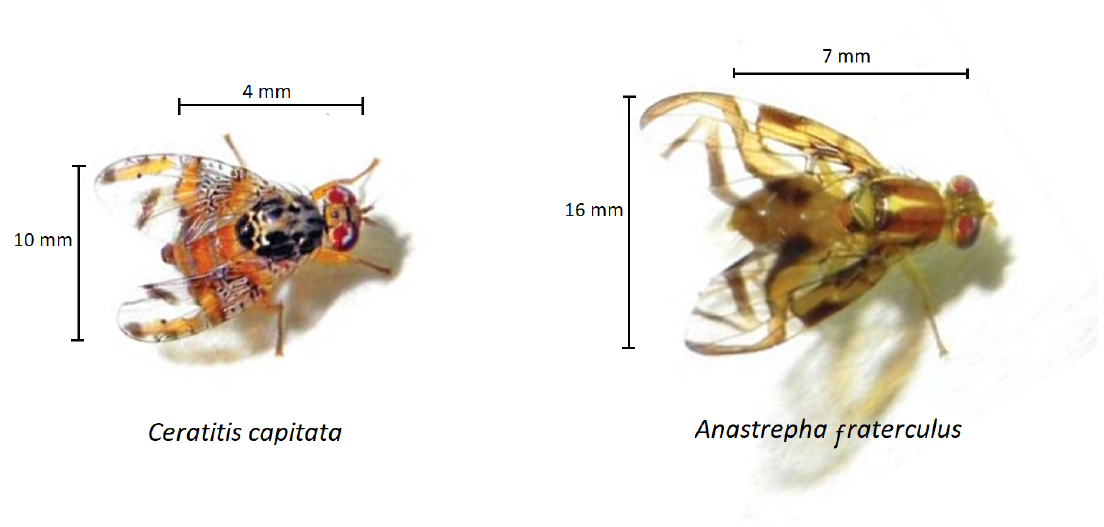
Figure 1. Fruit flies C. capita and A. fraterculus .